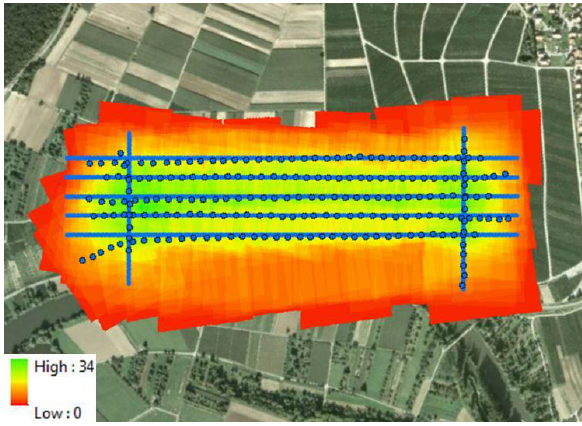
Figure 5: Image overlap as captured from UAV-flight.